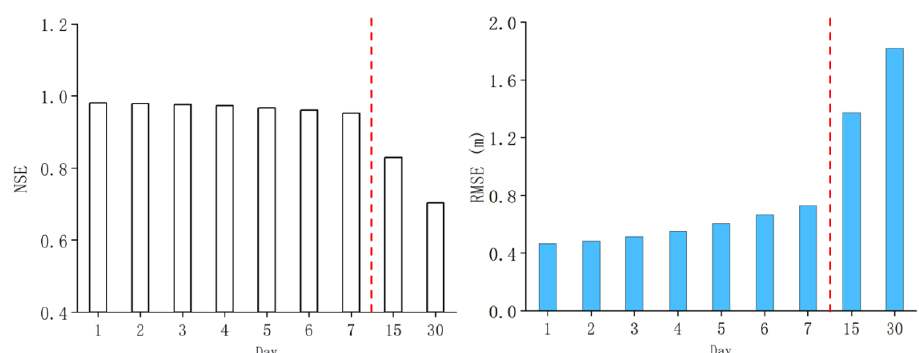
Figure 9. Effects of lead time on model accuracy in Xingzi Station. The red vertical line split the results into two groups to indicate the reason why the difference gap suddenly increased from day 7 to day 15: the left group are the prediction results for the coming 1 day to 7 days correspondingly; the right group are the prediction results for day 15 and day 30 respectively.